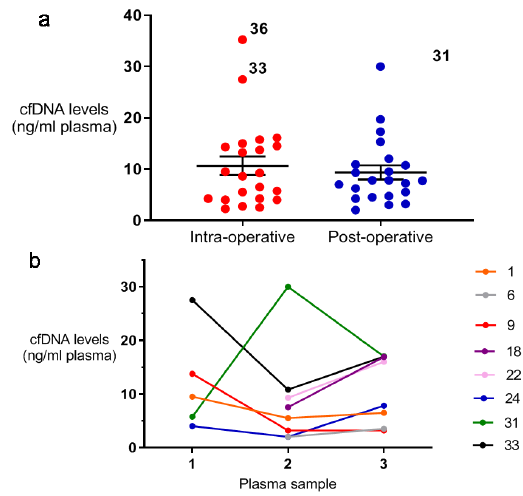
Figure 1. Analysis of cfDNA level in STS patients. ( a ) Peri-operative cfDNA levels in STS patients. The mean intra-operative cfDNA levels in patients with matched intra- and post-operative cfDNA levels available for analysis was 10.7 ng / mL ( ± 1.8 SEM, median 8.9, range 2.3 − 35.3) compared with 9.4 ng / mL ( ± 1.4 SEM, median 7.8, range 2 − 30) post-operatively ( p = 0.51, paired t test). Participant